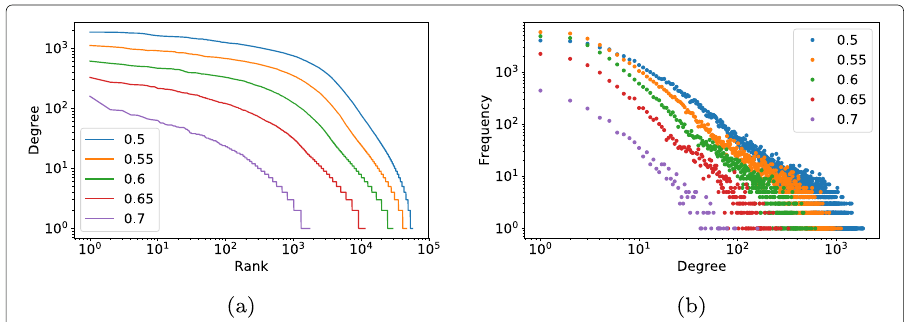
Fig. 3 Degree distributions of the largest connected component of the Google News word2vec embedding similarity networks (containing words from WordNet lexicon) sliced at five different thresholds (0.5, 0.55, 0.6, 0.65, and 0.7) on cosine similarity between the corresponding